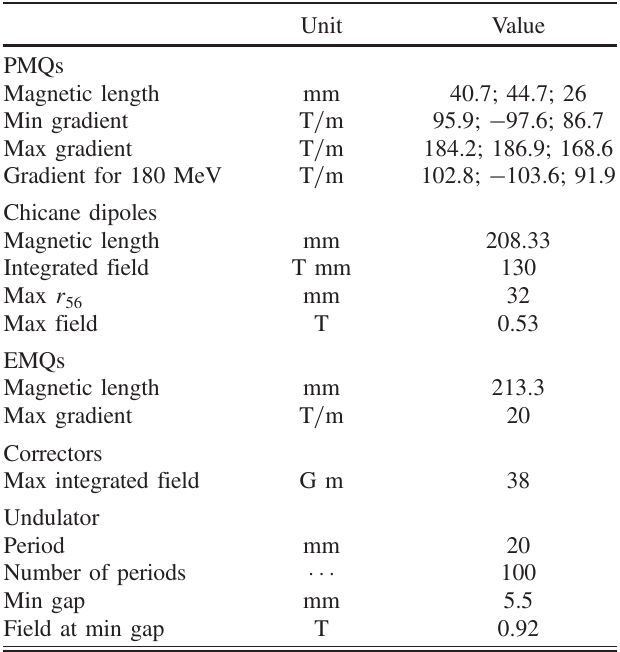
TABLE II. COXINEL magnets ’ relevant parameters. The three values for PMQs are for each PMQ of the triplet in the beam propagation